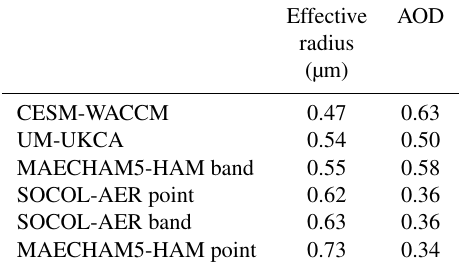
Table 4. Global stratospheric mean when SO 4 >